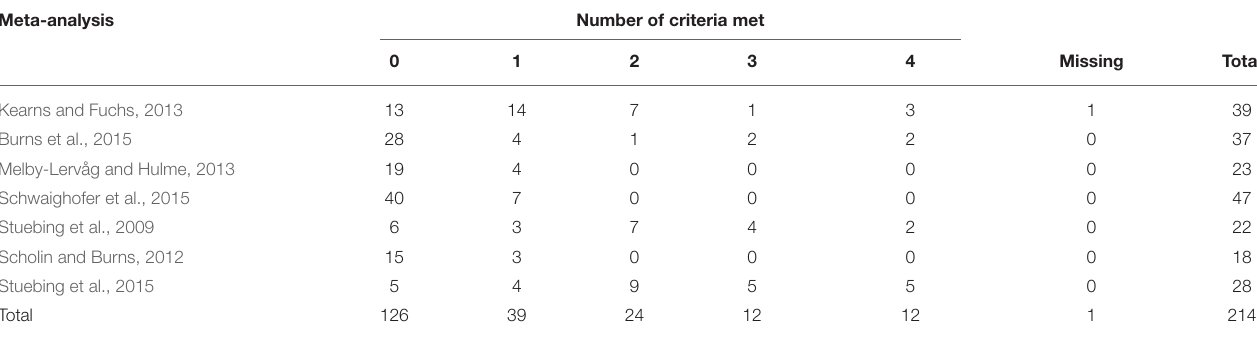
TABLE 9 | Coding summary of evidence quality (0 to 4 with higher ratings representing higher quality of evidence) for research studies included in each meta-analytic study. Meta-analysis Number of criteria